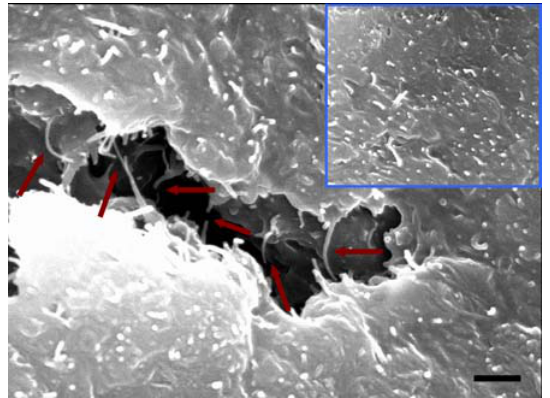
Figure 5. SEM micrograph of the fracture surface for TLCP nanocomposites containing 1.5 wt% of modified CNT (Scale bar: 500 nm). The inset show uniform dispersion of CNT in TLCP matrix. The arrow indicates that CNT were to be broken with their ends still embedded in TLCP matrix or they were bridging the local microcracks in TLCP nanocomposites, suggesting good wetting with TLCP matrix and enhanced adhesion between them, thus being favorable to efficient load transfer from TLCP to CNT. Reproduced with permission from Ref. [43]. © 2008 Elsevier